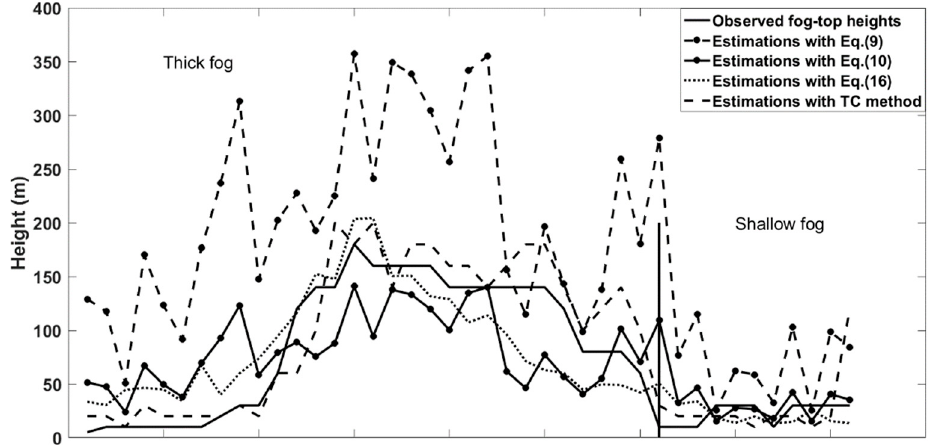
Figure 7. Observations of fog-top height, fog-top height estimations with H = 1369 × u * − 28 (Equation (9)), H = 583.35 × u *1.12 (Equation (10)), H = 396.26× ( σ w + 0.1 × w * ) – 16 (Equation (16)), and the TC method (in Equation (17)) during a shallow and thick fog events in 2018.